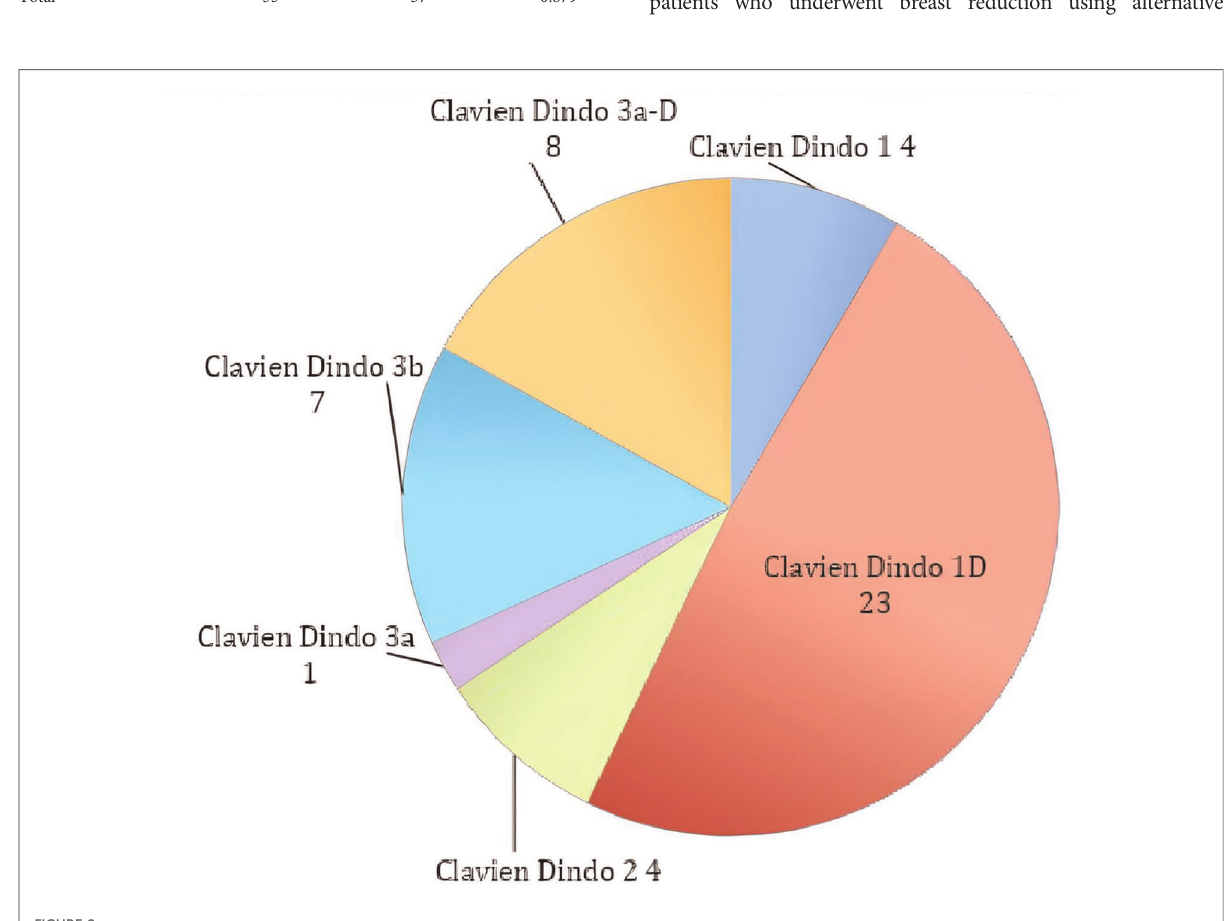
FIGURE 2 Complication sub-classi fi cation of group